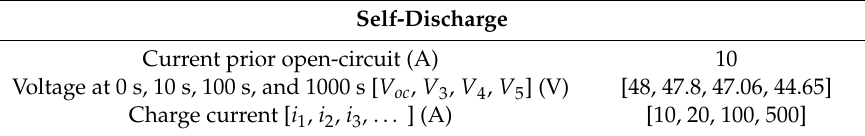
Table 6. Supercapacitor (SC) self-discharge